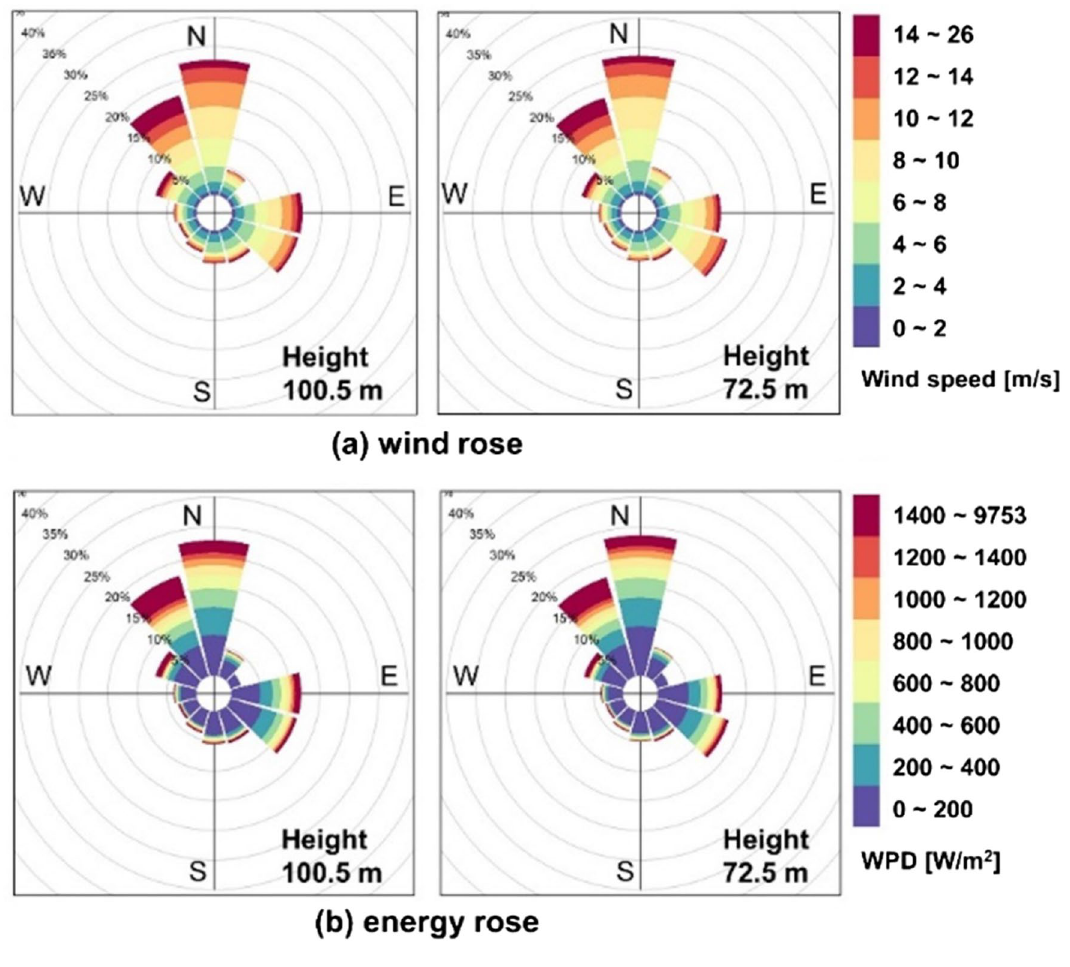
Figure 6. Wind and energy